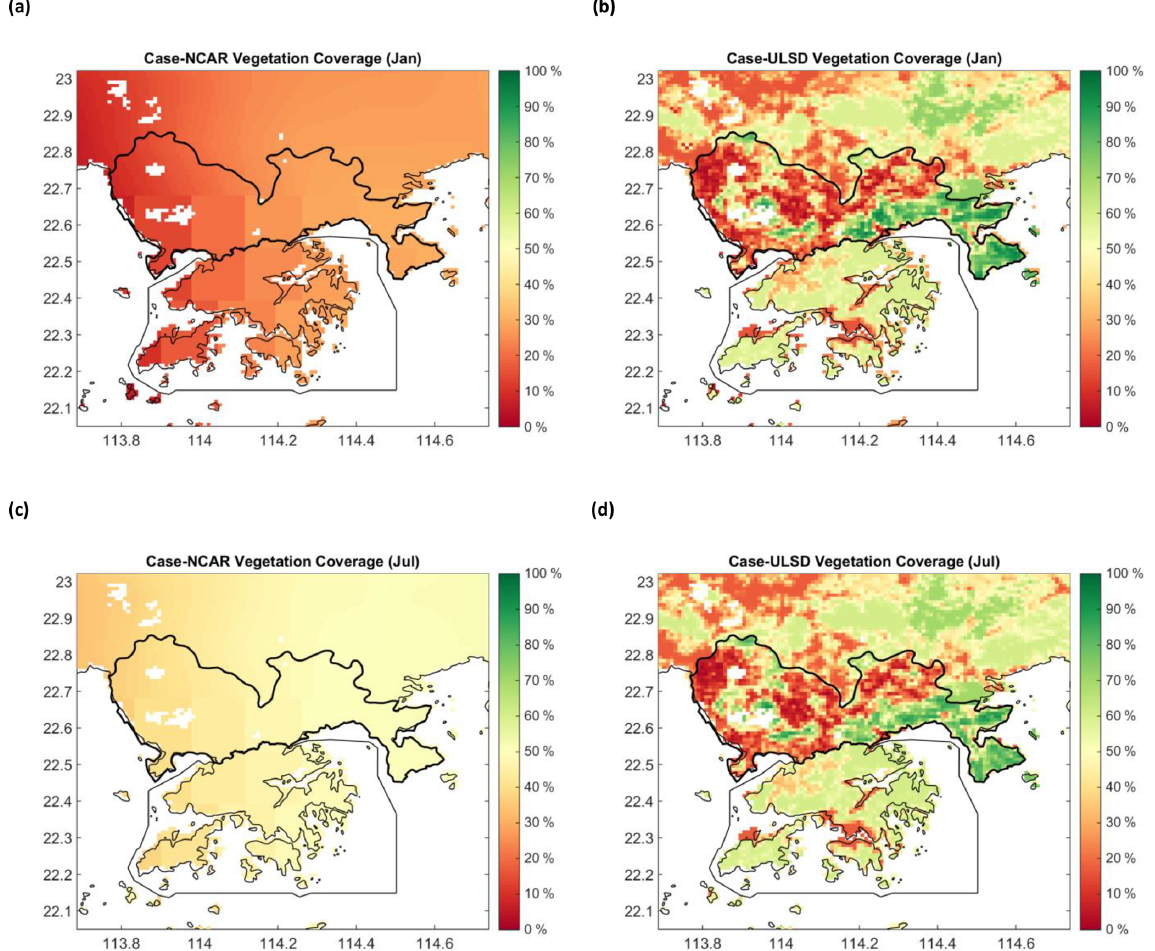
Figure 3. The original (a, c) and refined (b, d) vegetation coverage data product in January ( a, b , local winter) and July ( c, d , local summer). Data source: Li et al. (2019a, b).